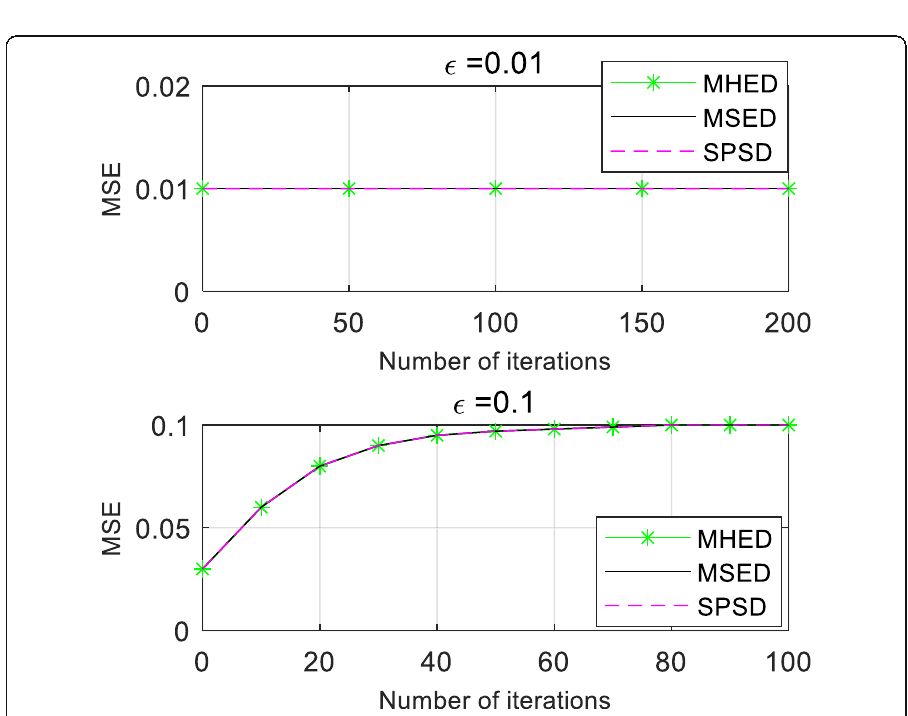
Fig. 9 The variance of the MSE achieved by the three schemes under the constraints of ε = 0.01 and ε = 0.1. y -axis represents the MSE; x -axis represents the number of iterations. There are two subgraphs in the figure. The upper one represents the MSE achieved by the MSED, MHED, and SPSD under the MSE constraint of ε = 0.01; the bottom one represents the MSE achieved by the MSED, MHED, and SPSD under the MSE constraint of ε = 0.1. The black solid line represents MSED; the green line represents MHED; the red dotted line represents